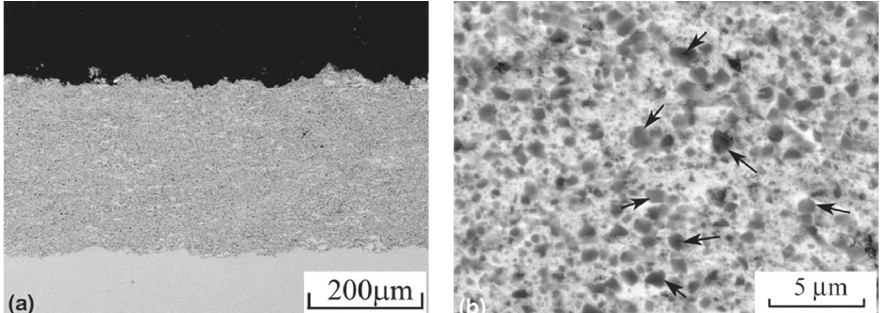
Figure 22: SEM imaging of cold sprayed cBN-NiCrAl MMC coatings with 40 vol.% cBN [49]. The bright regions and dark dots in (b) correspond to NiCrAl alloy and cBN